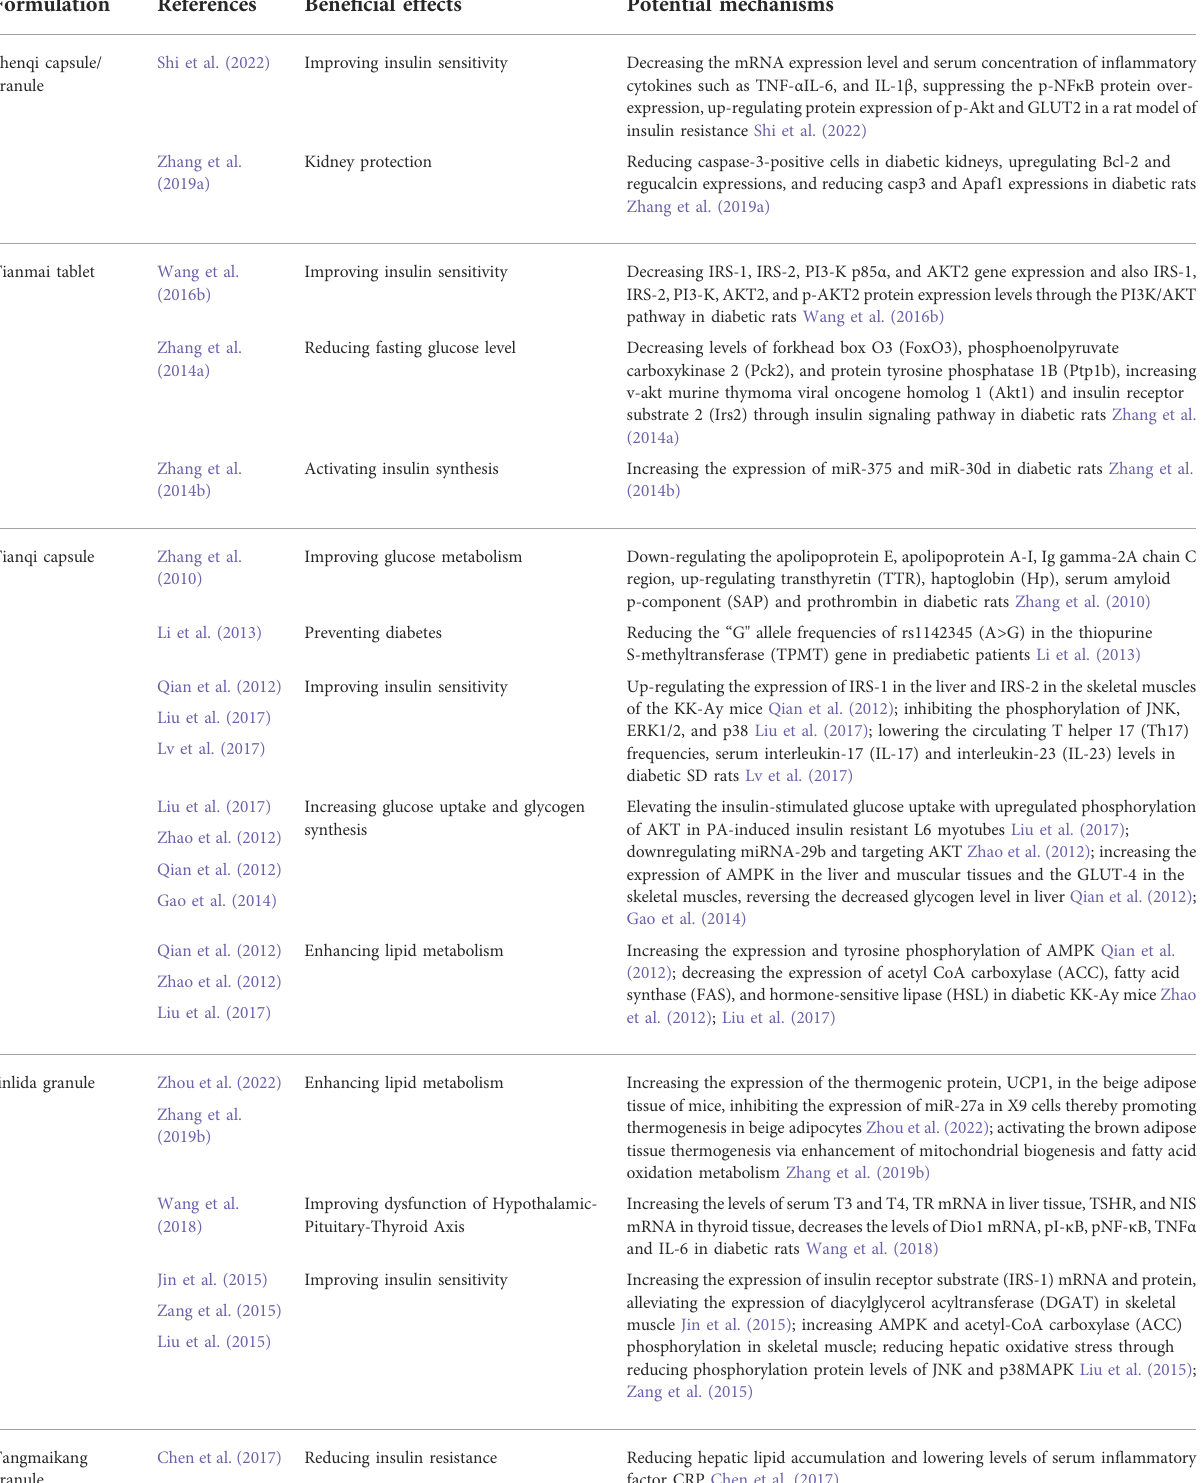
TABLE 3 Potential mechanisms of 6 TCPM on prediabetes and T2DM in vivo experiments.